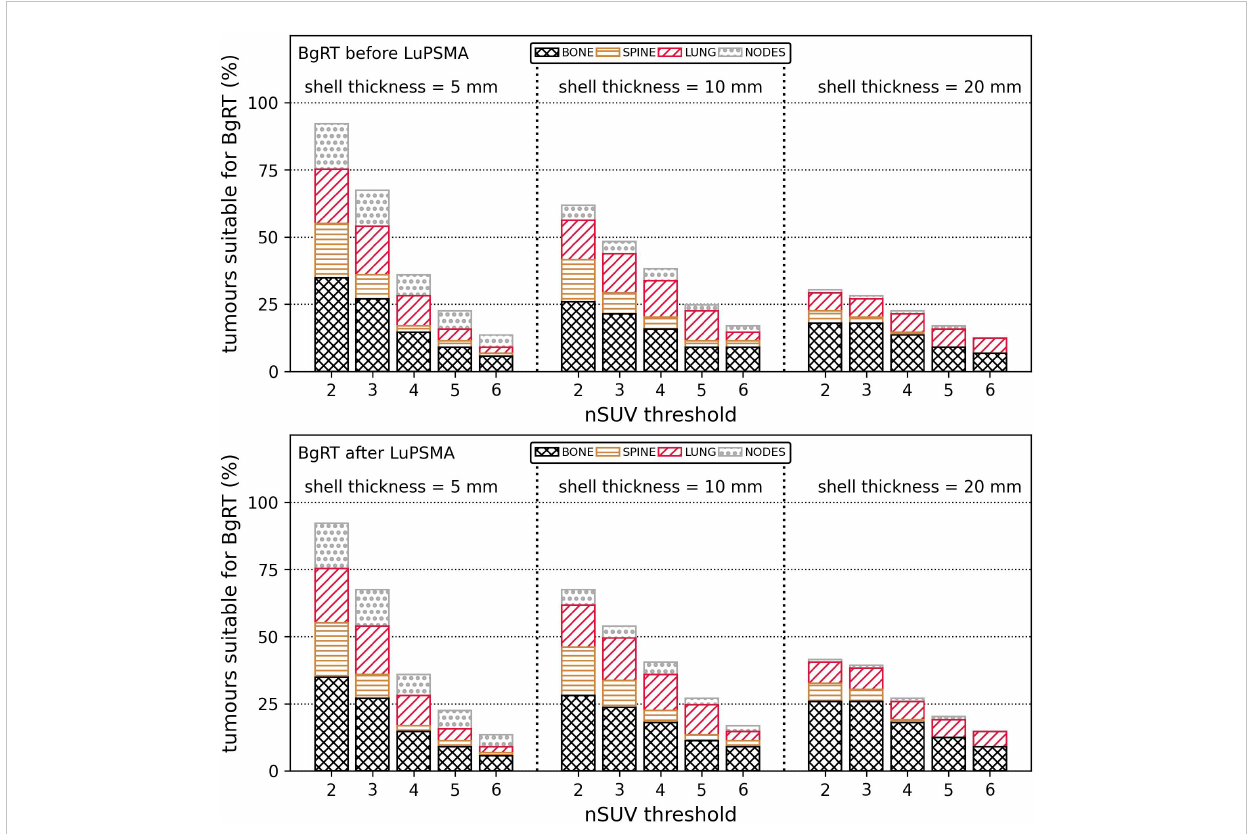
FIGURE 3 Proportion of tumours (%) suitable for BgRT (nSUV ≥ nSUV threshold and absence of PET uptake in the BTZ) depending on if the BgRT treatment was performed before (top row) or after (bottom row) LuPSMA cycle. Results were classi fi ed per anatomical site. The proportion of suitable tumours is shown for nSUV threshold between 2 and 6 and for shell thickness of 5 mm/10 mm/20 mm. BgRT, Biology-guided radiotherapy; nSUV, Normalised standardised uptake value, PET, Positron emission tomography; BTZ, Biological tracking